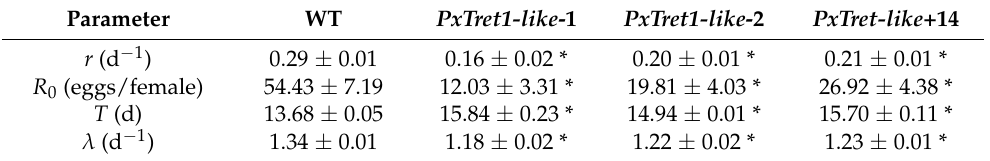
Table 2. Population parameters of different PxTret1-like mutants and wild-type strain in different generations. Parameter